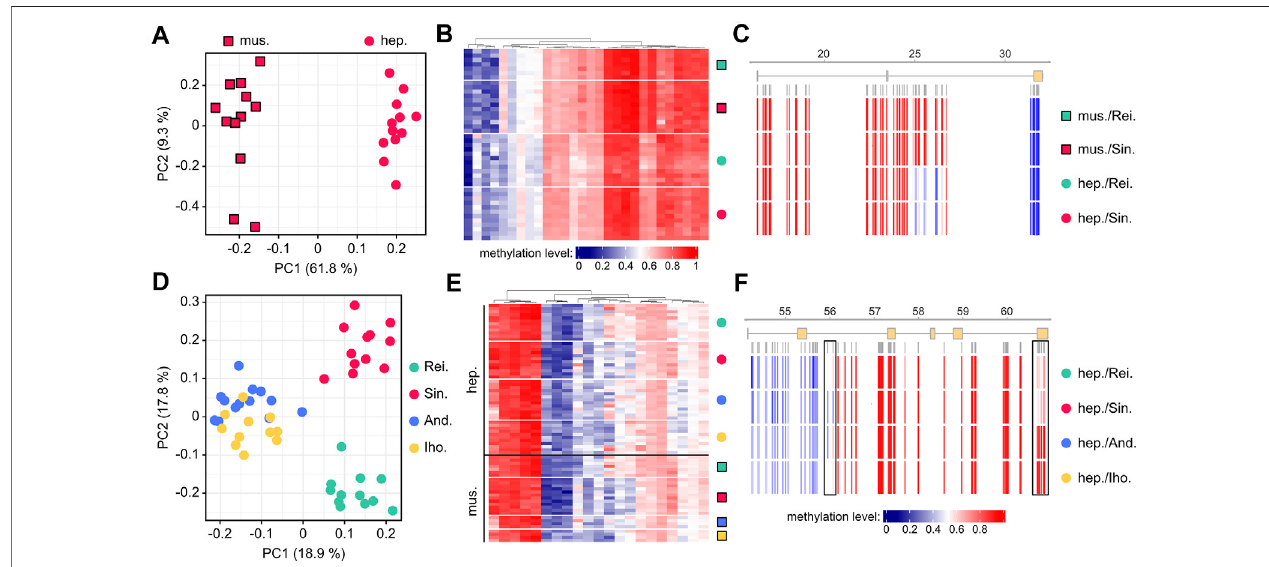
FIGURE 4 | Location-dependent differential methylation in marbled cray fi sh populations. (A) Principal component analysis of individual abdominal muscle (mus, square symbols) and hepatopancreas (hep, circular symbols) samples from Singlis, based on the methylation levels of 56 genes with tissue-speci fi c methylation differences. (B) Heatmap showingaveragemethylationlevels of28shared (Singlisand Reilingen)geneswithtissue-speci fi cmethylation. Methylation levelsareindicated on a scale from 0 (blue) to 1 (red) for Reilingen (green symbols) and Singlis (red symbols). (C) Average CpG methylation levels in a gene with tissue-speci fi c methylation. (D) Principal component analysis of individual hepatopancreas samples from all locations, based on the methylation levels of 122 genes with location- speci fi c methylation differences. (E) Heatmap showing average methylation levels of 21 shared (hepatopancreas and abdominal muscle) genes with location-speci fi c methylation. Methylation levels are indicated on a scale from 0 (blue) to 1 (red), as in panel B. (F) Average CpG methylation levels in a gene with location-speci fi c methylation. Boxes highlight differentially methylated